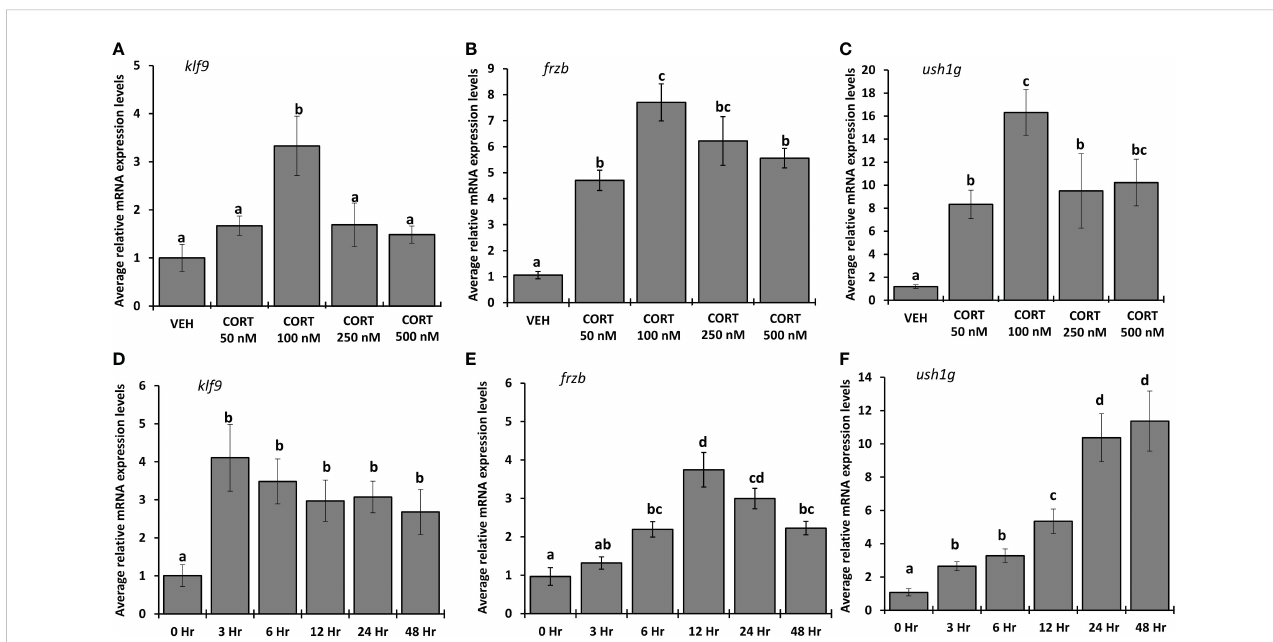
FIGURE 6 Dose response and time course for CORT induction of frzb, ush1g , and klf9 in tadpole tails. (A-C) Premetamorphic tadpoles (NF 54) were treated with vehicle and 50, 100, 250, and 500 nM of CORT (corticosterone) for 24 hours. (D-F) Premetamorphic tadpoles (NF 54) were treated with 100 nM CORT for 0, 3, 6, 12, 24, and 48 hours. Tails were dissected from tadpoles followed by RNA extraction and quantitative PCR to measure mRNA expression of frzb, ush1g , and klf9 and the housekeeping gene rpl8 . Bars represent mean mRNA levels relative to rpl8 and normalized to a vehicle control sample. n = 10 tail samples per treatment. Error bars represent SE. Letters indicate signi fi cant groups, p < 0.05.